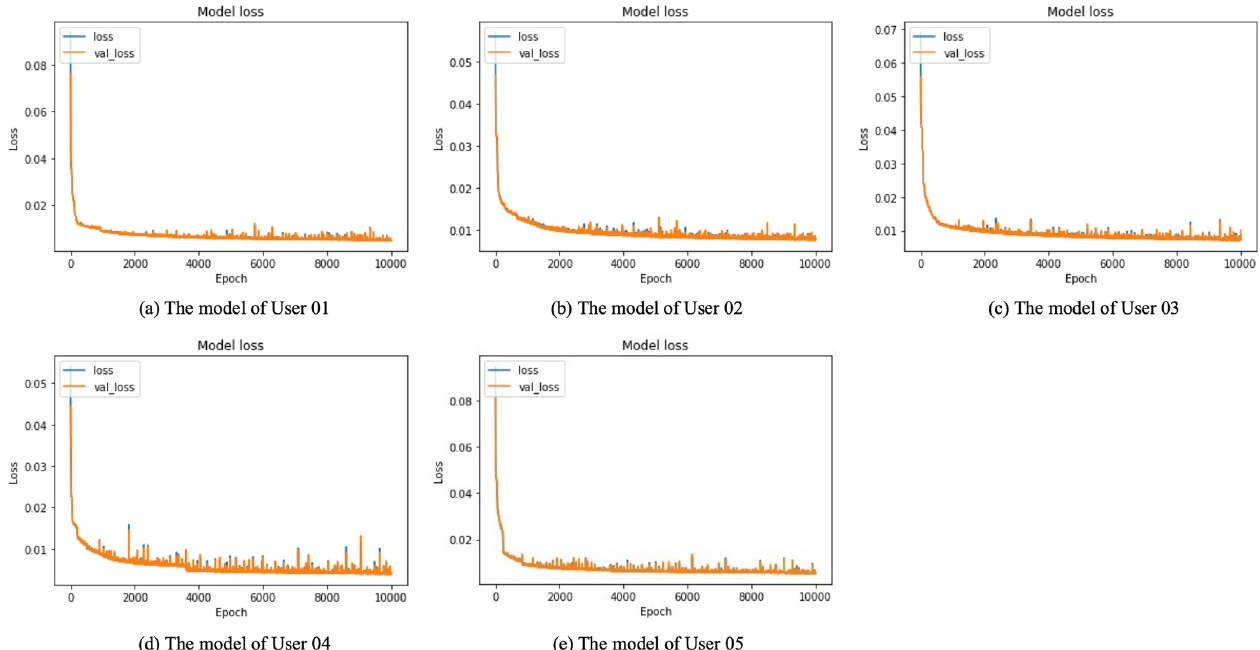
Figure 4. Learning curves of model loss in the five autoencoder models.